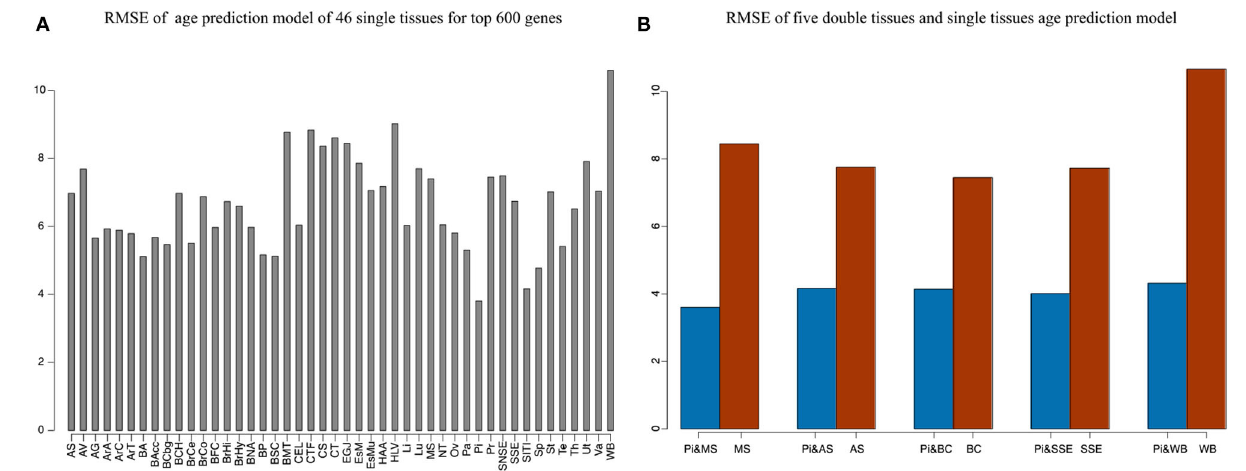
FIGURE 2 | The accuracy of 46 single tissues and five double tissues in age prediction. (A) The RMSE of single tissue age predictors for the top 600 genes. We select the top 50, 100, 200, 400, 600, 800, 1,600, 3,200, and 6,400 genes, which are obtained via Pearson correlation of age and gene expression, and then build the age-prediction model across the 46 single tissues. Because the best predictive model appears in the top 600 genes, here we show the RMSE of the top 600 gene model. As can be seen from the figure, the minimum RMSE is 3.8, which corresponds to the age-prediction model of pituitary tissue. (B) Blue represents the RMSE of the top 600 genes of pituitary and the top 50 genes of muscle, adipose subcutaneous, brain cerebellum, skin sun exposed, and whole blood, and brown represents RMSE of the first 50 genes of muscle, adipose subcutaneous, brain cerebellum, skin sun exposed, and whole blood.